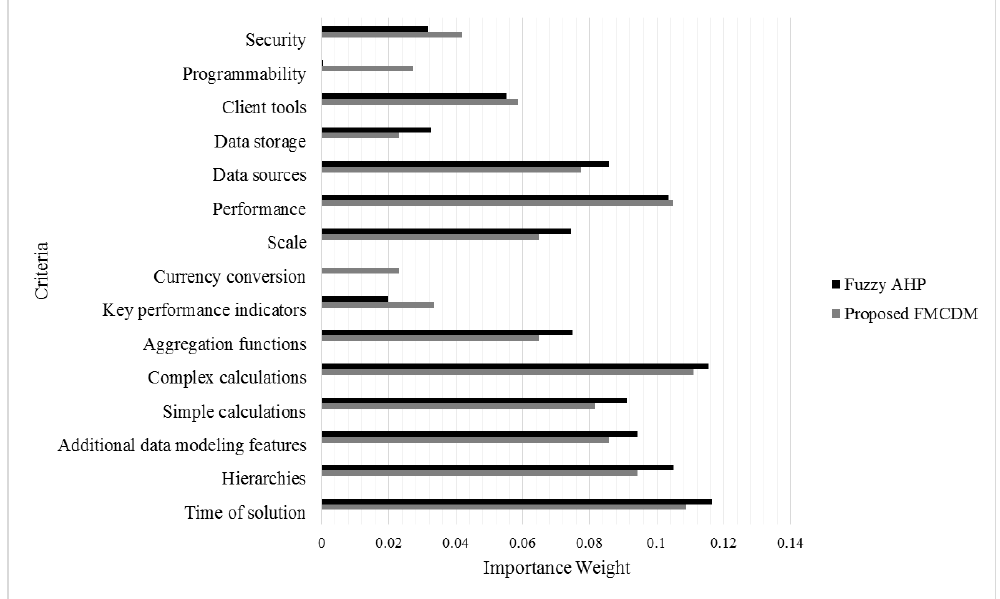
Figure 4. Importance weights of criteria for selected data source.